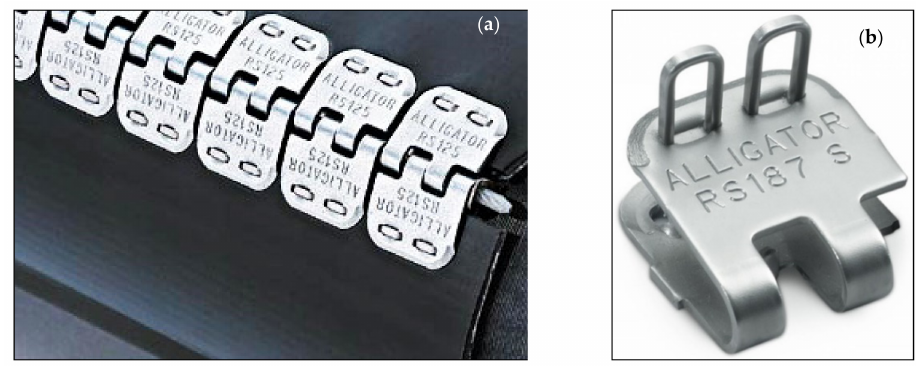
Figure 8. Staple fastening: ( a ) general view; ( b ) single fastener [25]. Table 1. Fasteners resistant ranging from one plus sign (+) to four plus signs (+ + + +) [25]. Material of Fastener. Magnetic